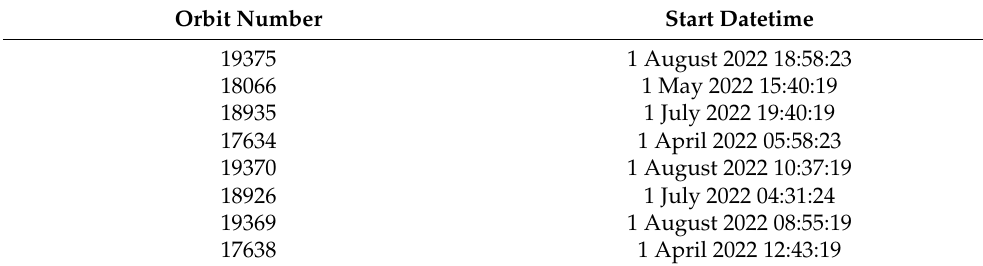
Table 5. AMSU-A/MHS orbit and start datetime used for